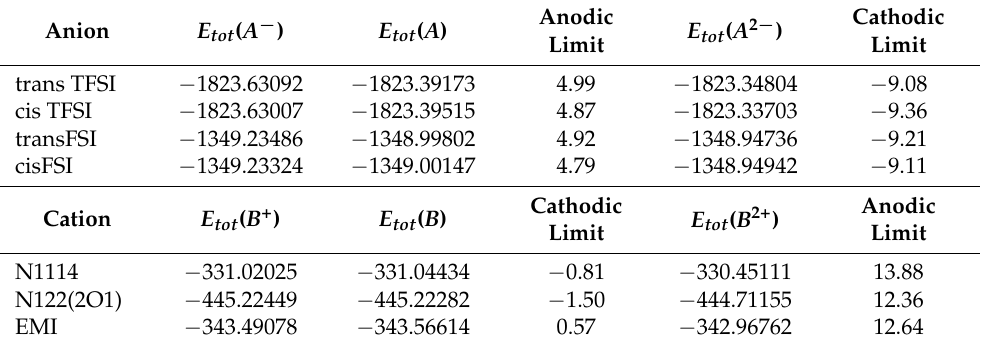
Table 1. Electronic energy (in atomic units) of anions and cations and their unrelaxed neutral or double charged forms calculated at the MP2/6-31G** level of theory and derived anodic and cathodic limit (V).